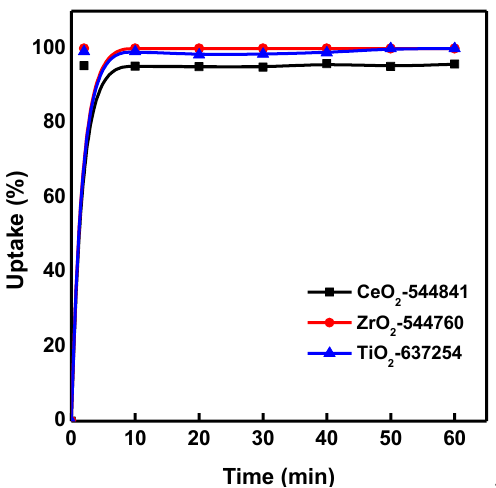
Figure 6. Effect of contact time on CA- 99 Mo uptake on different metal oxide NPs (C 0 = 50 mg ∙ L – 1 , pH = 3, V/m = 100 mL ∙ g – 1 , and temperature = 298 ± 1 K).